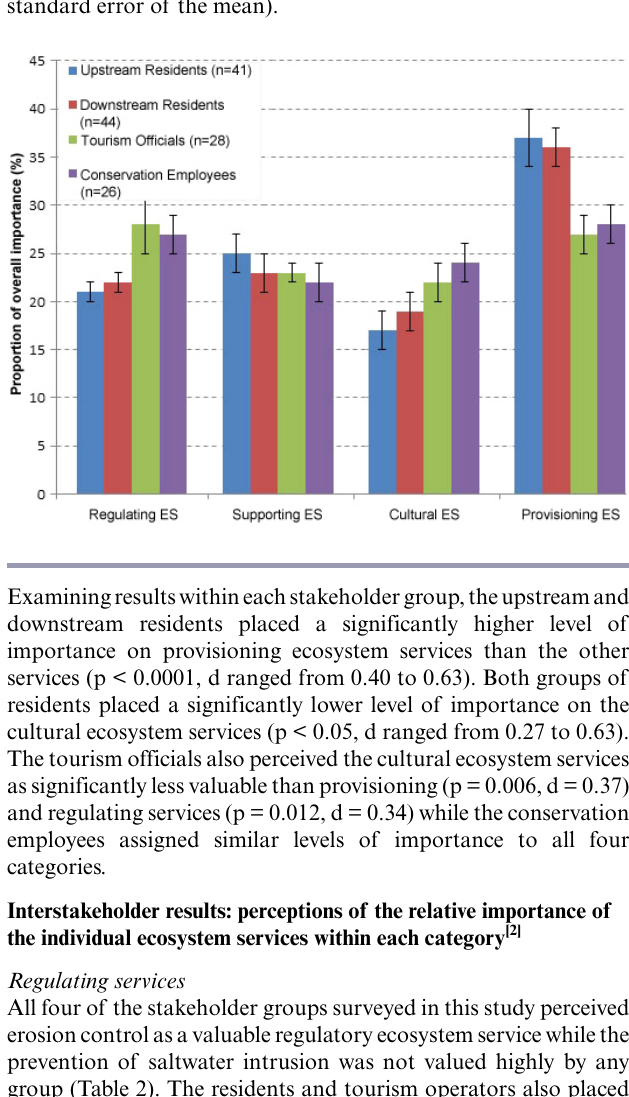
Fig. 2 . Relative valuation assigned to each category of ecosystem services by residents, tourism, and conservation stakeholders. (Columns represent mean values. Vertical error bars represent the standard error of the